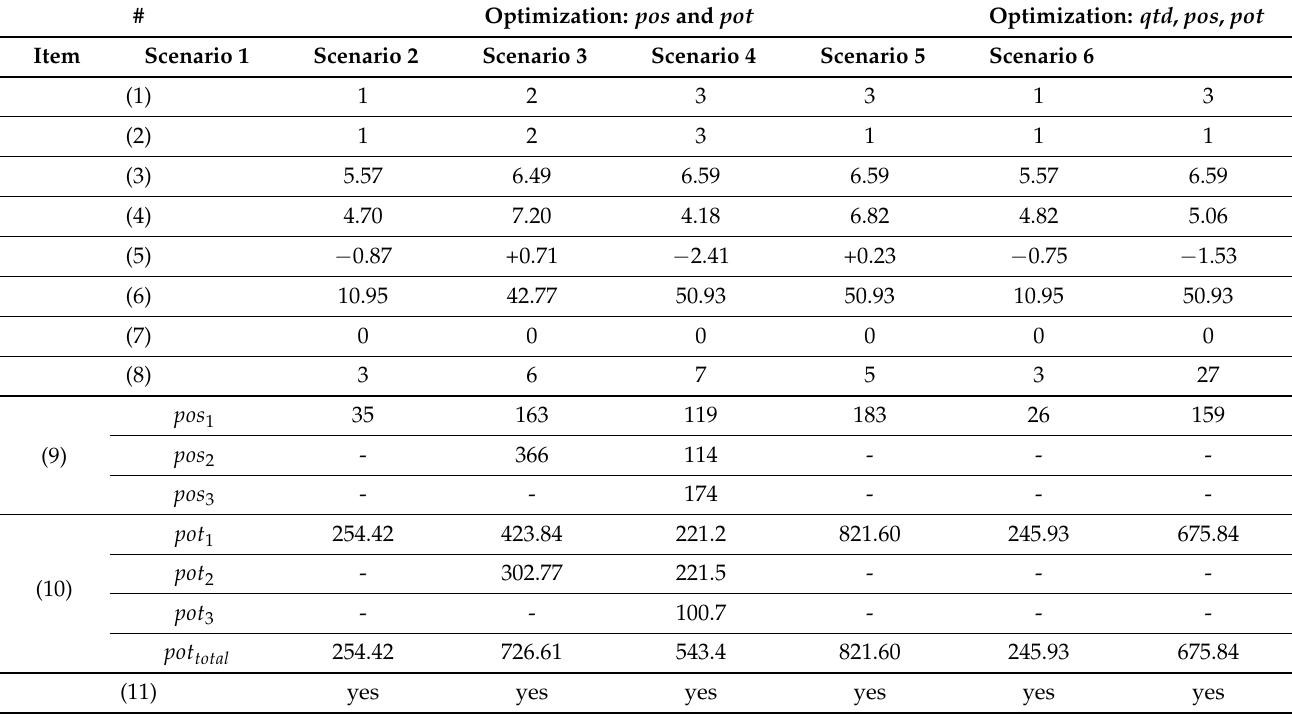
Table 8. Values obtained from the allocation and optimization processes for all